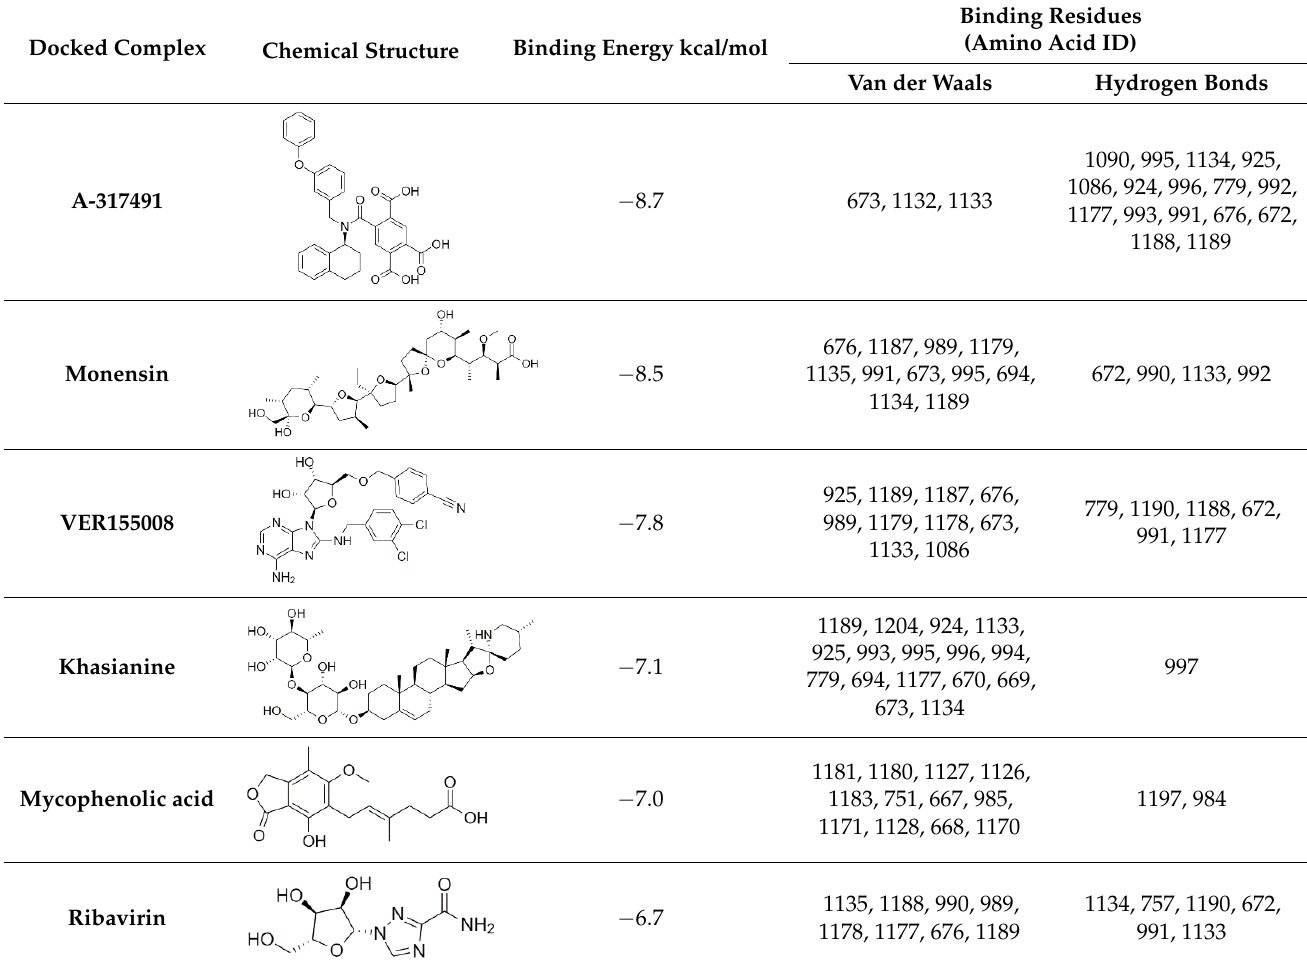
Table 1. Binding energy and binding residues of docked complexes.